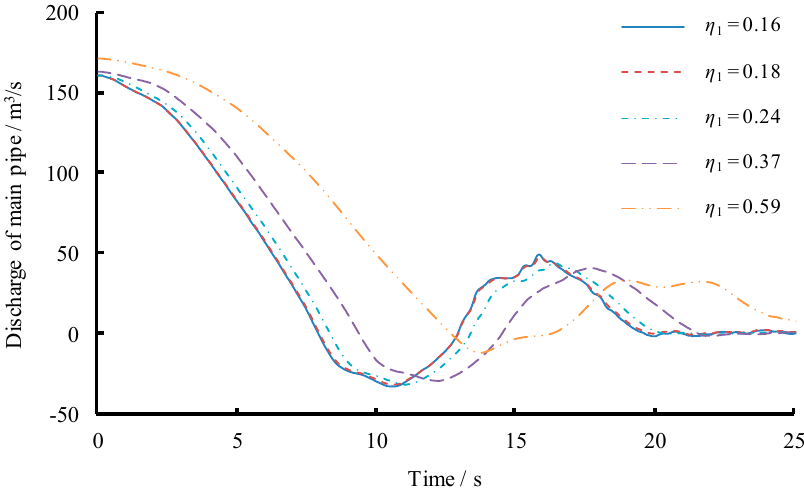
Figure 15. Main pipe discharge of different η 1 versus time for Scenario 2.